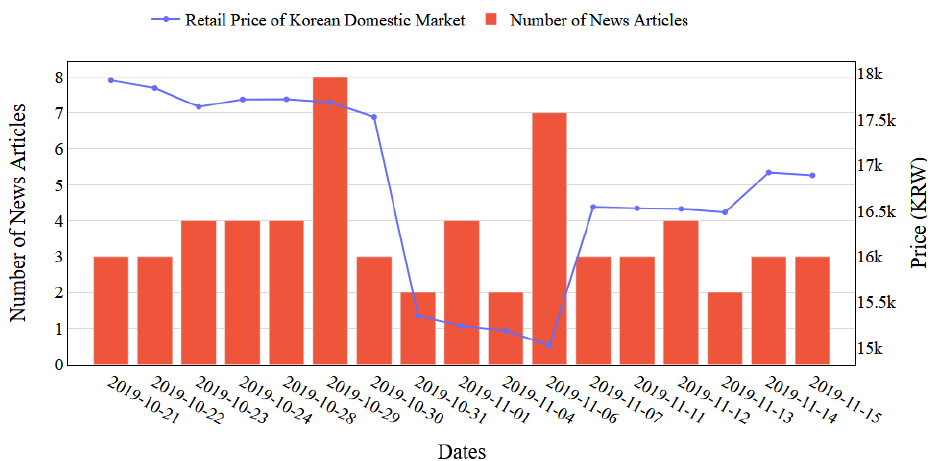
Figure 1. E ff ect of news articles on the price of Figure 1. Effect of news articles on the price of pork.